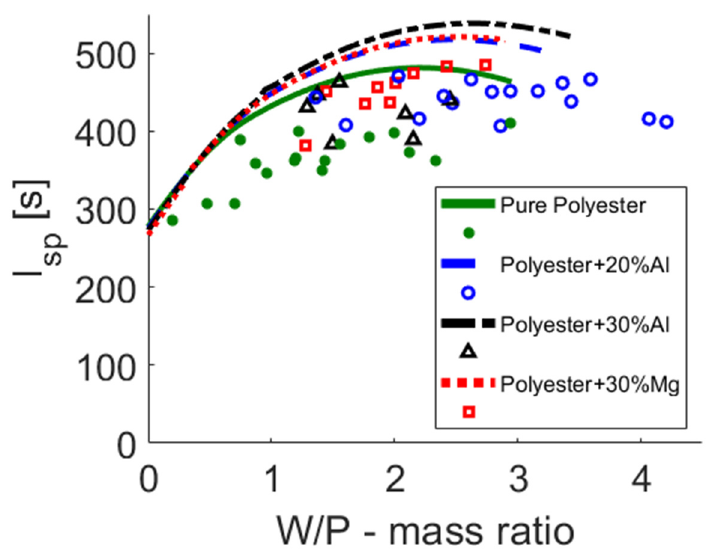
Figure 9. A comparison between the standard theoretical and experimental specific impulse of a hybrid-propellant, water-breathing ramjet operating with a variety of hydro-reactive fuels and non-hydro-reactive fuel vs. the water – propellant mass ratio.